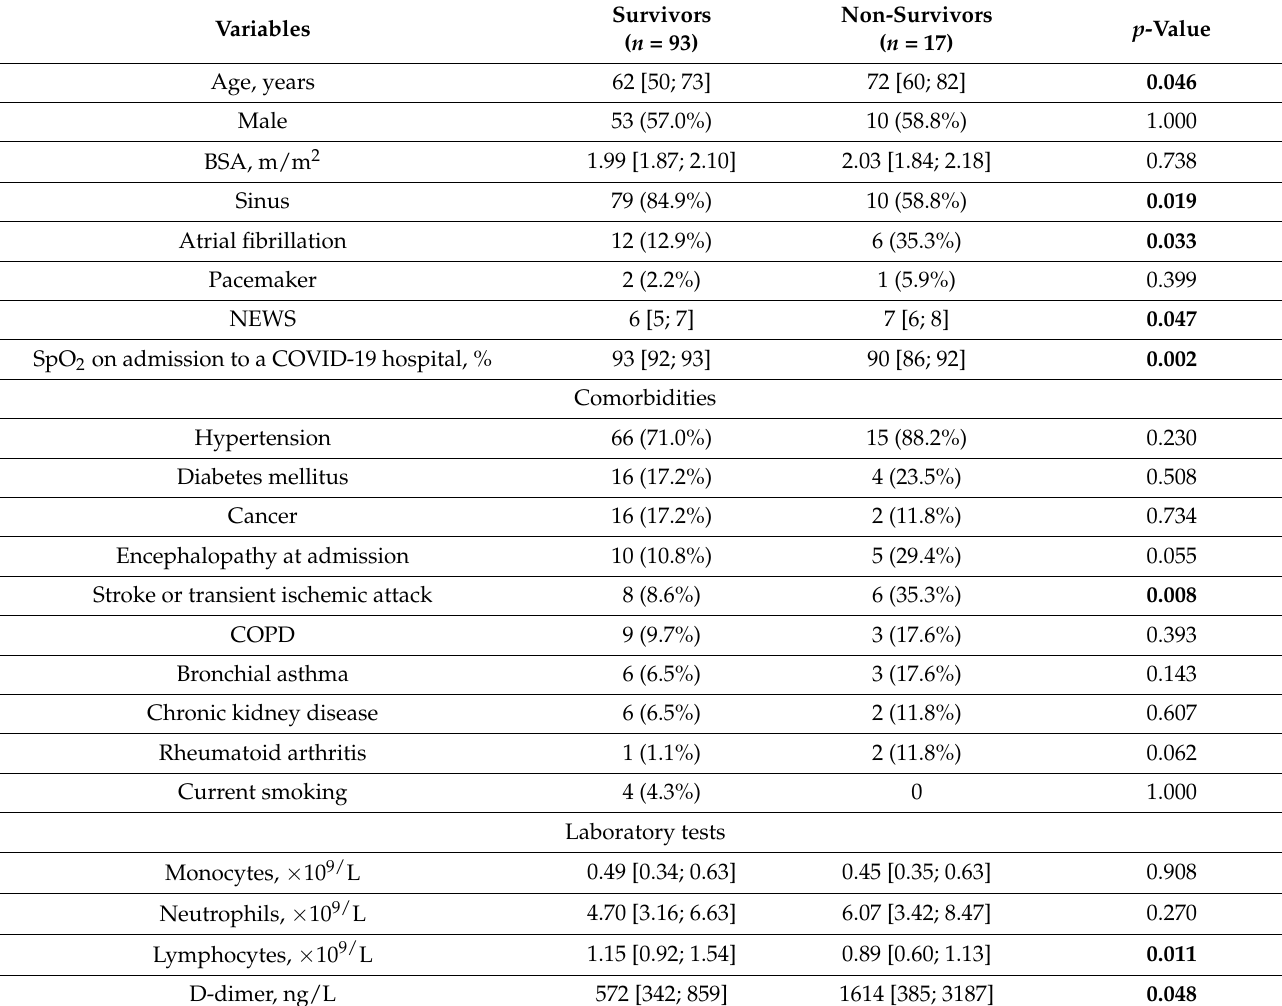
Table 2. Comparison of different parameters depending on survival